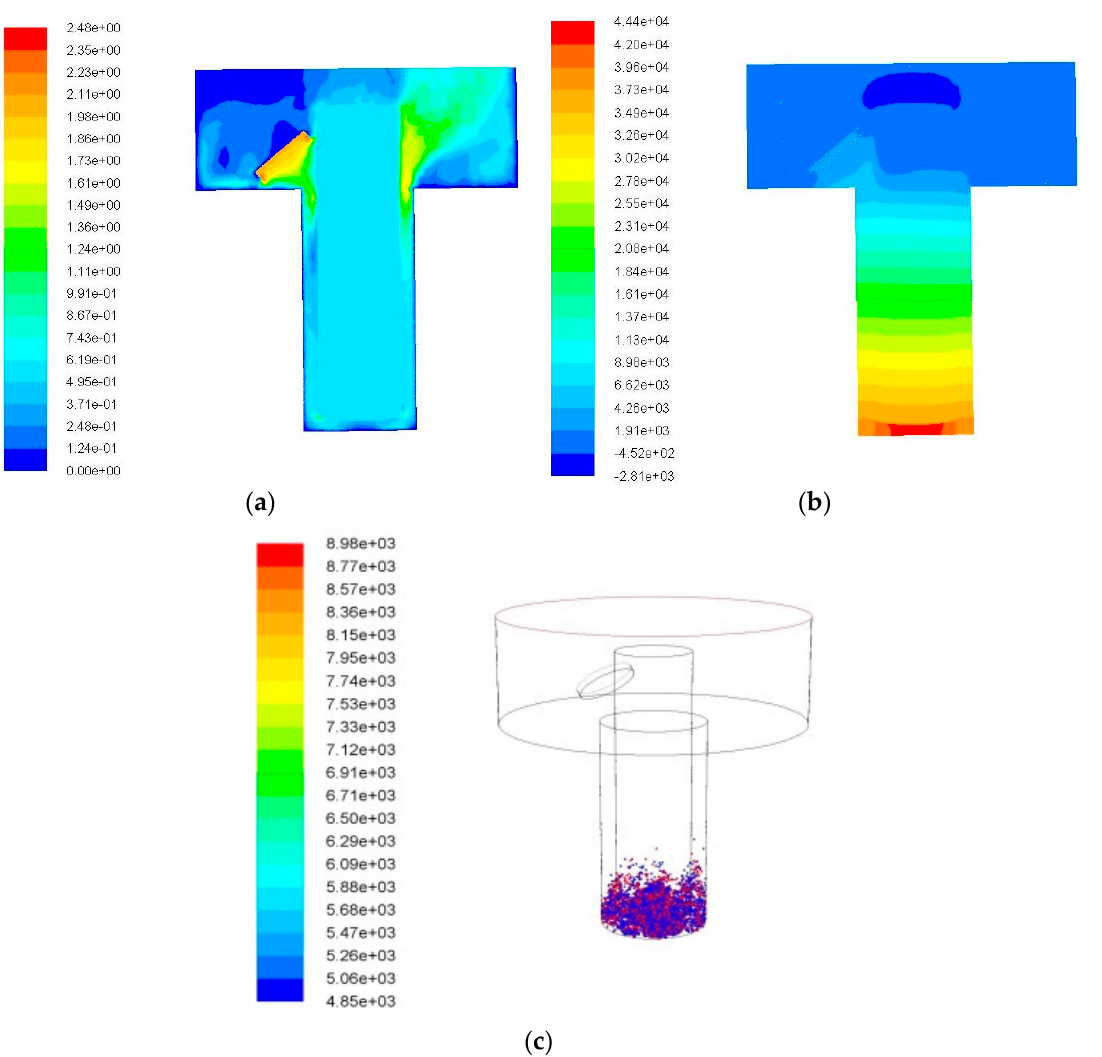
Figure 5. Machining with ultrasonic vibration. ( a ) Velocity field; ( b ) Pressure field; and ( c ) Debris distribution.